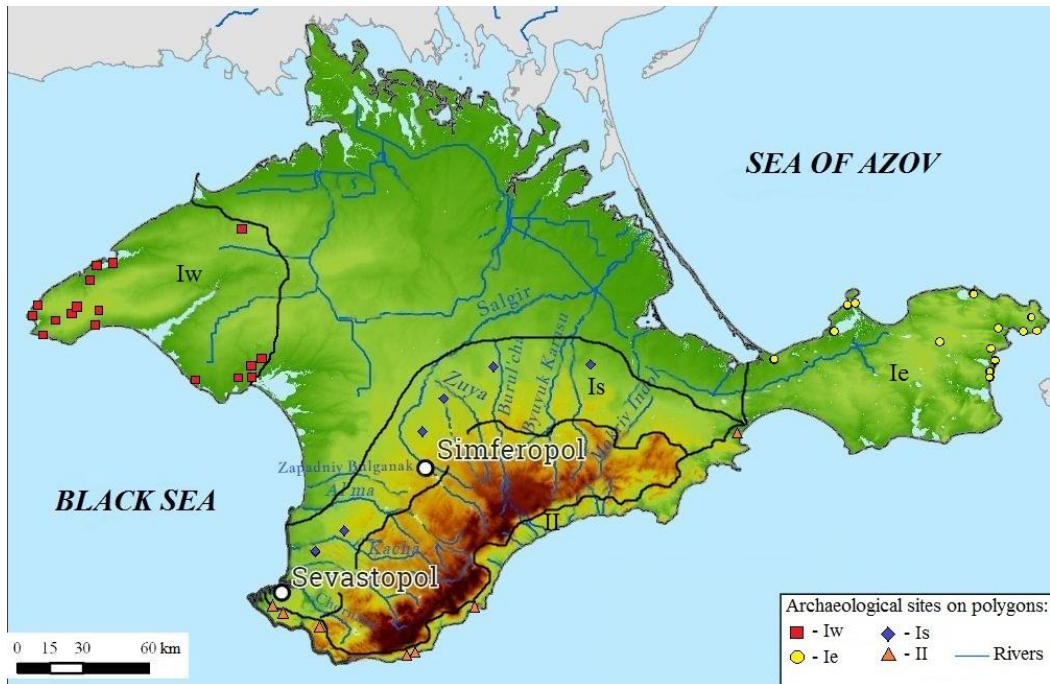
Figure 1. Archaeological sites (from which the studied soils are found) within the research polygons, in the territory of the Crimean Peninsula within the boundaries of the natural areas. I denotes the Crimean Plainland (West, East) and Foothills (South), and II denotes the South Coast of Crimea (SCC).